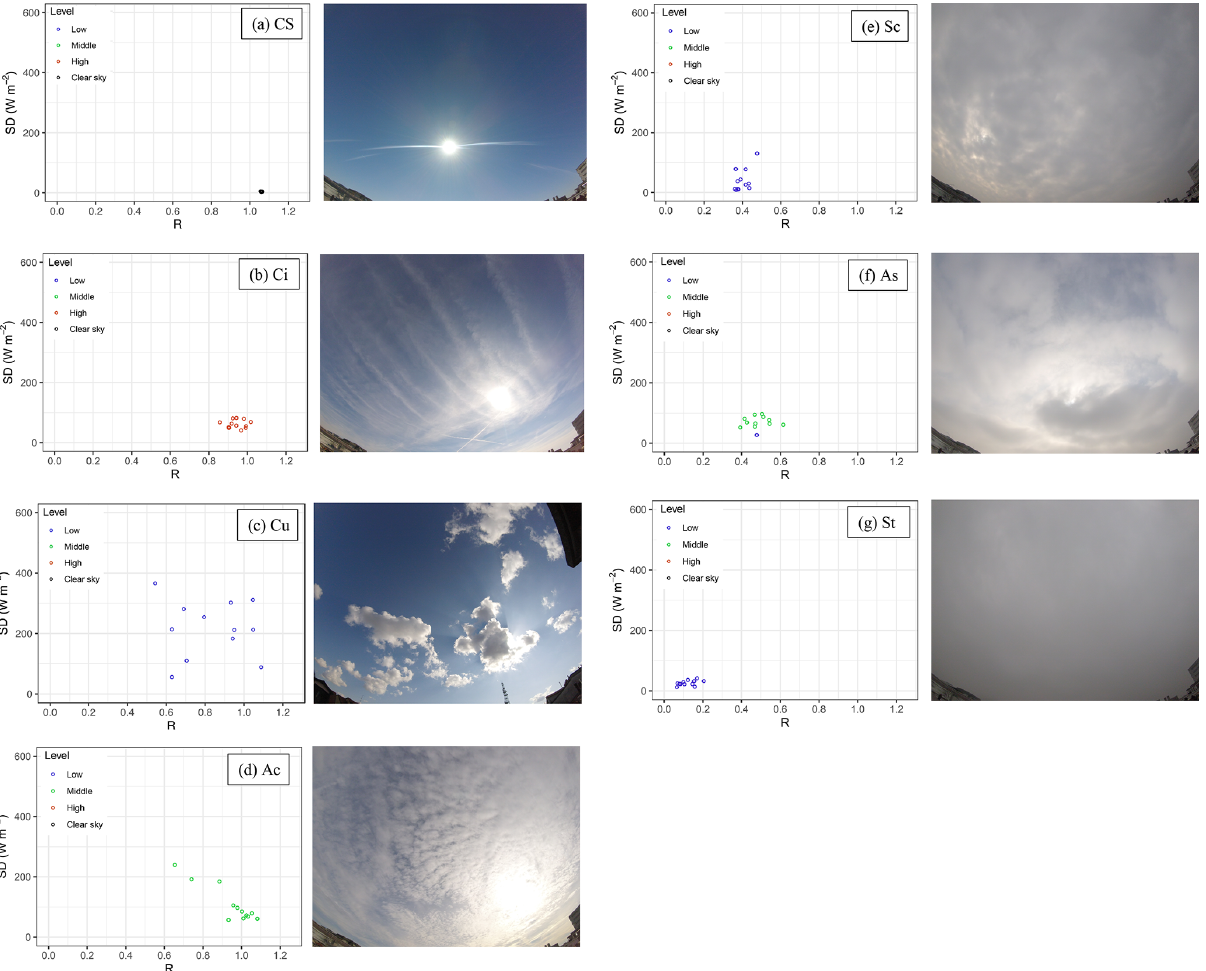
Figure B1. SD– R diagram (a–g) and the corresponding sky images for the February–March 2017 field campaign: (a) CS conditions, (b) Ci clouds, (c) Cu clouds, (d) Ac clouds, (e) Sc clouds, (f) As clouds and (g) St clouds. Table B1. Confusion matrix and balanced accuracy for each cloud type classified visually and following the algorithm reported in Table 1 within the present